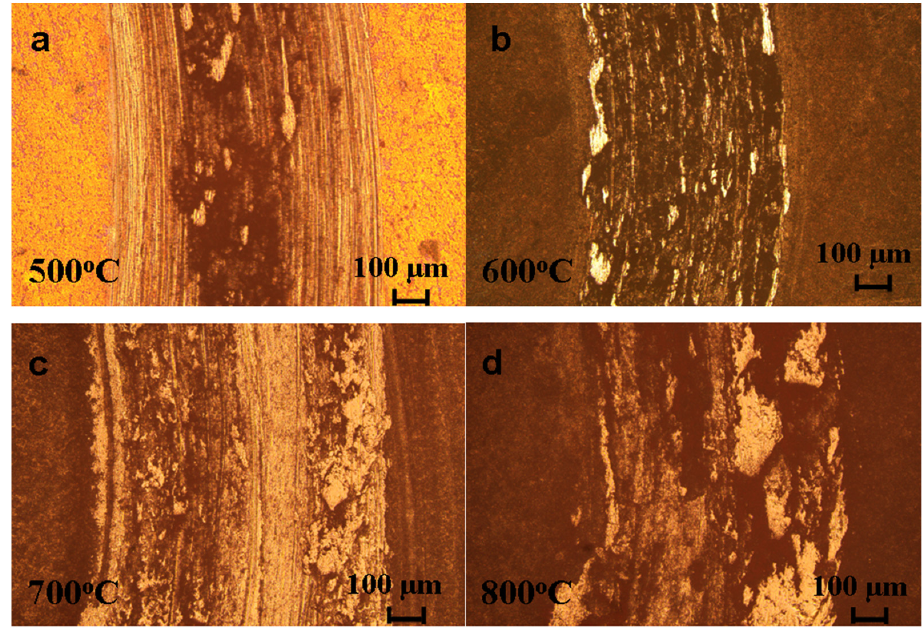
Figure 7. CoF of the uncoated steel and h-BN coatings under different temperatures.